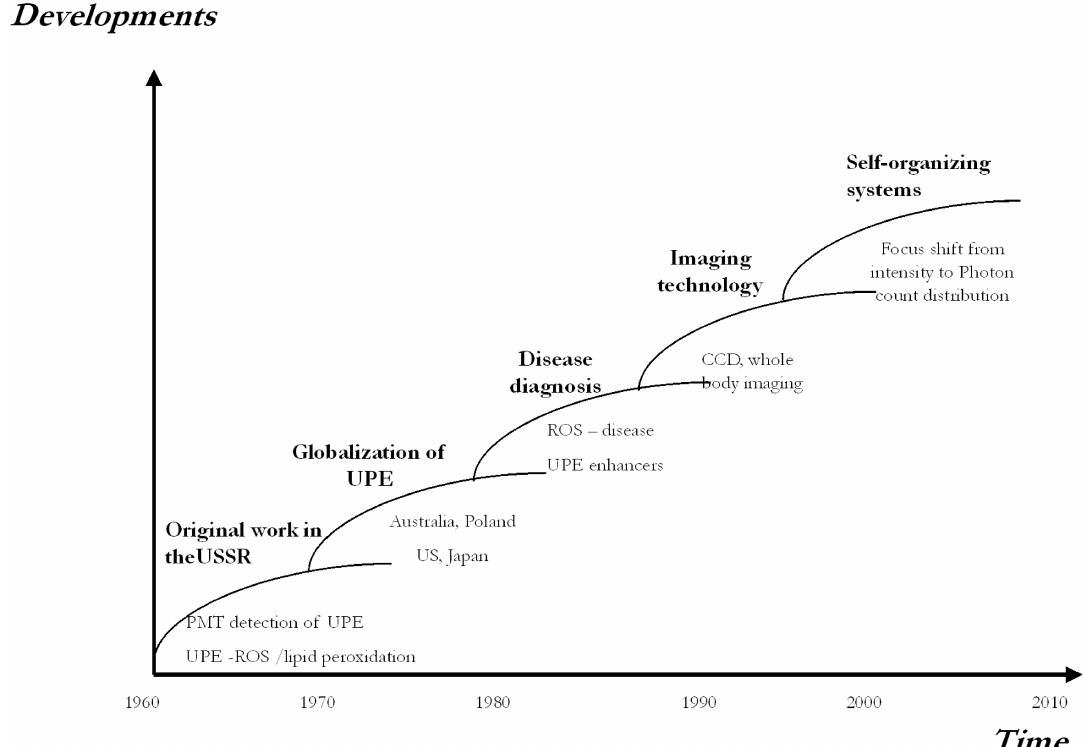
Figure 1. Major trends in UPE developments in the last 50 years. The historical development of this field can be subdivided in five main areas: (1) the initiation of research of UPE with photomultiplier tubes in USSR and its connection to radical oxygen species (ROS) and lipid peroxidation, (2) the recognition of UPE world wide and globalization of this research, (3) the use of UPE as a non-invasive diagnostic marker, (4) the extension of time measurement into spatial patterns, and (5) the use of photon count distributions (PCD) and statistics (PCS) (based on fluctuations in the number of photons in successive counting in contiguous measurement times) for detecting a ‘light language’ that is connected with the system’s organization of the living biological